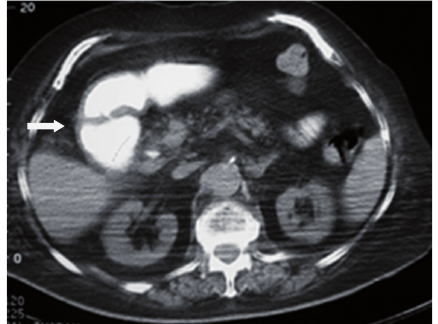
Figure 4: Dilatation of the duodenum